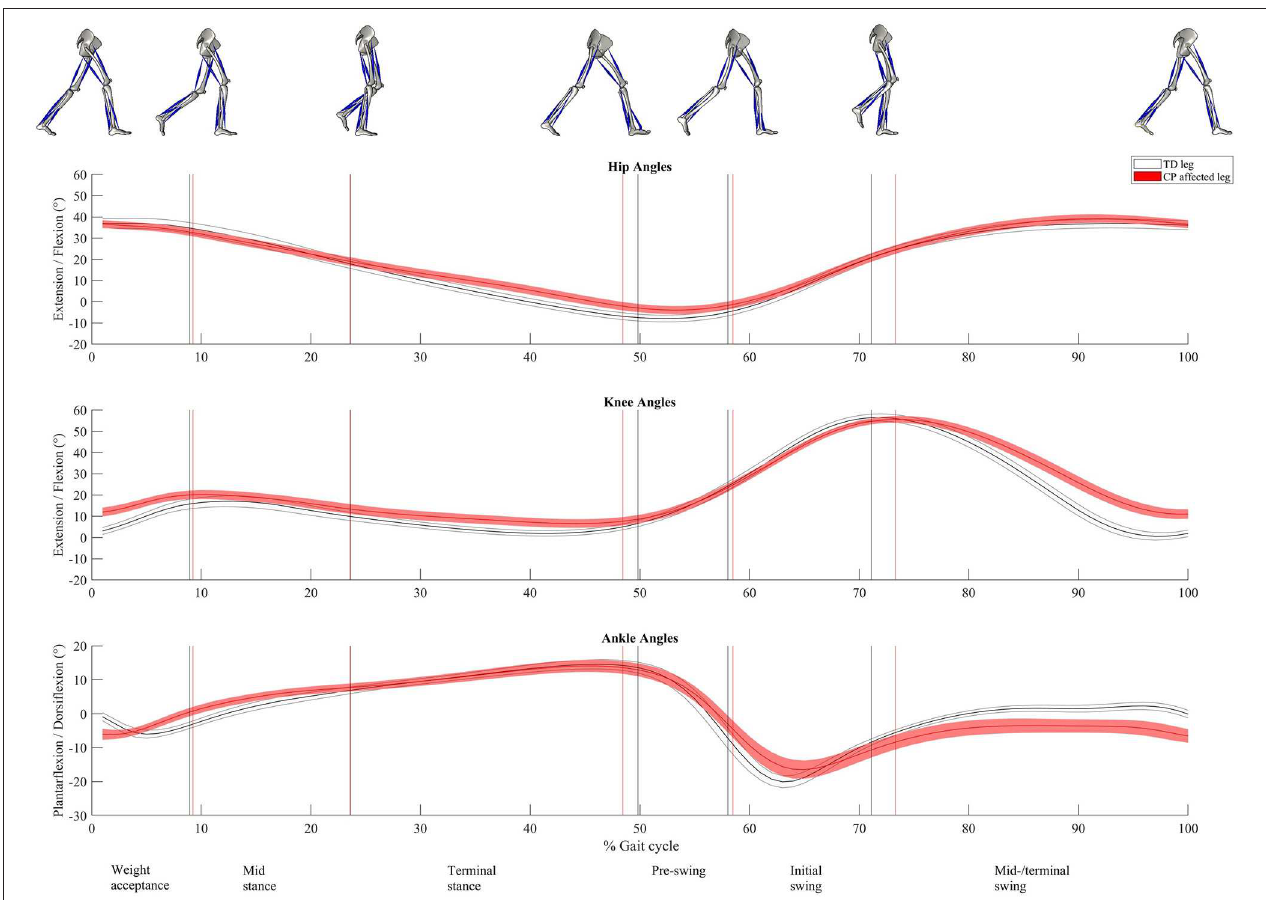
FIGURE 2 | Sagittal-plane joint kinematics. At the top hip extension/flexion; in the middle, knee extension/flexion; and at the bottom, ankle plantarflexion/dorsiflexion. Time normalized to 0 to 100% of the gait cycle. Presented as mean (solid line) with 95% confidence interval (shaded area). The vertical lines represent the mean timing of the different events dividing the gait cycle into six gait phases (named at the bottom line). Gray color is used for the healthy legs of typically developing children and red for the affected legs of children with CP. Illustrations of the right leg’s events, separating the different phases, are seen at the top.